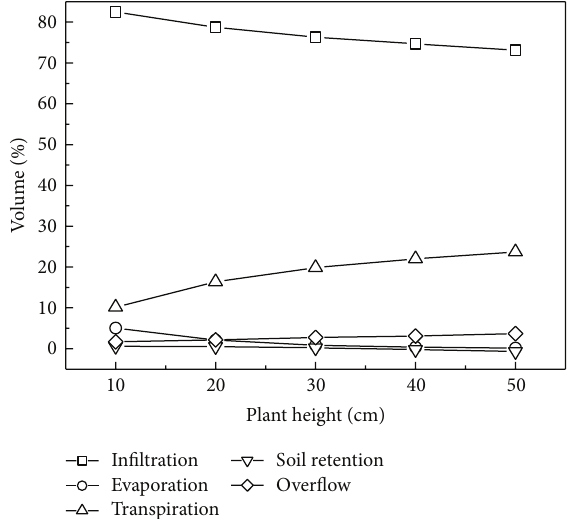
Figure 10: Water volume variation in bioretention systems with different plant